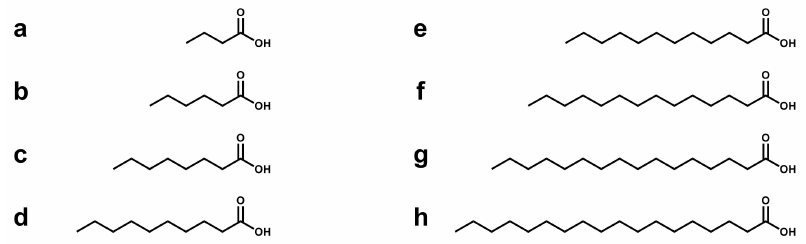
Figure A1. Chemical structures of saturated fatty acids tested in this study. ( a ) Butyric acid; ( b ) hexanoic acid; ( c ) octanoic acid; ( d ) decanoic acid; ( e ) dodecanoic acid; ( f ) myristic acid; ( g ) palmitic acid; ( h ) stearic acid.